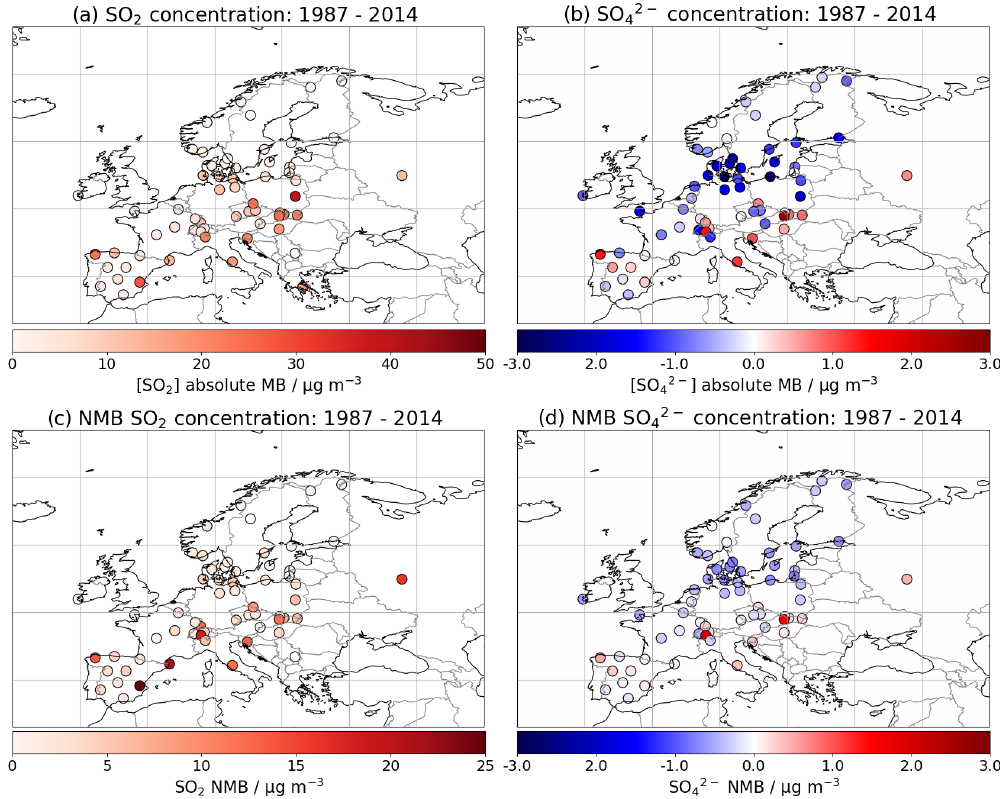
− concentration at EMEP measure- 4